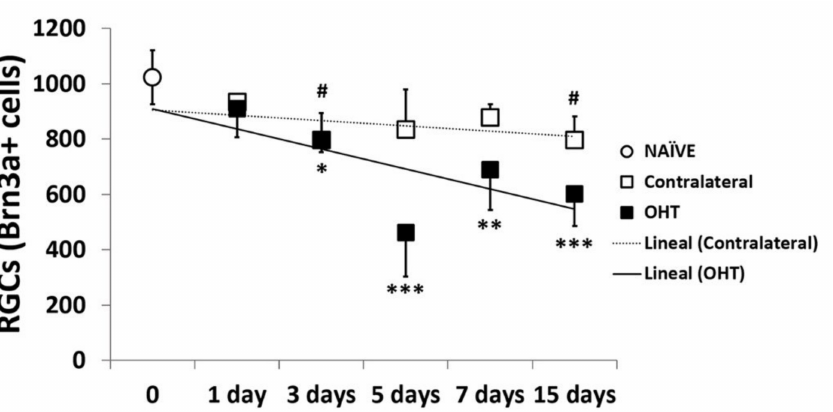
Figure 12. The variation over time in the number of Brn3a+ cells in the immunohistochemical assay. Points show the mean levels ( ± SD) of Brn3a+ cells at days 1, 3, 5, 7, and 15 after laser OHT induction in control naïve eyes, ocular hypertension eyes (OHT), and in contralateral eyes. Statistical significance indicators: * p < 0.05, ** p < 0.01, *** p < 0.005, OHT vs. control naïve; # p < 0.05, contralateral vs. control naïve. Abbreviations: RGCs (retinal ganglion cells); Brn3a (brain-specific homeobox/POU domain protein 3A); OHT (ocular